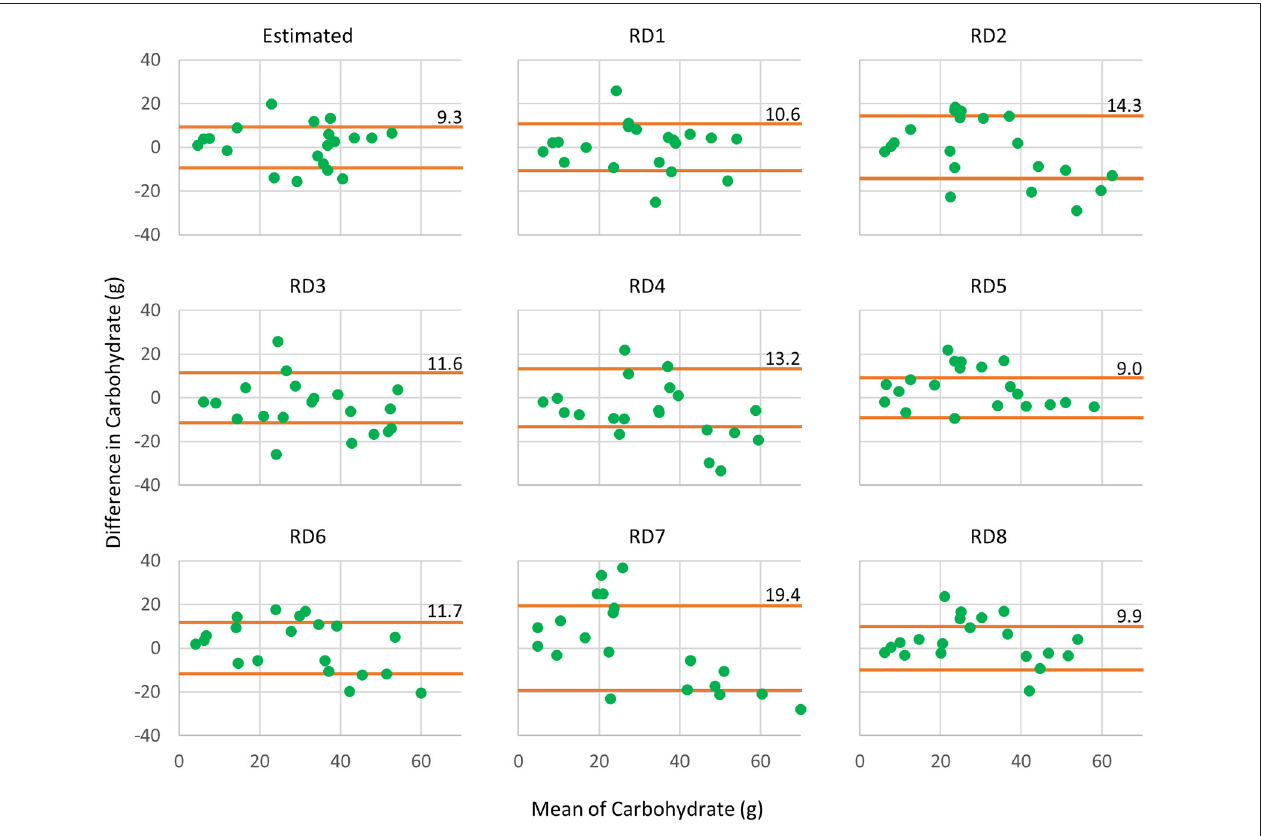
FIGURE 6 | Bland–Altman plots show agreement between calculated carbohydrate content of Measured, Estimated, and RDs. The orange lines are limits of agreement between other methods against Measured.